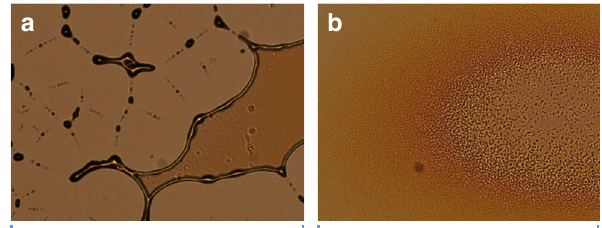
Fig. 5 In fl uence of the accumulated neutral molecule. Optical microscopy images (scale bars 540 µ m) of surfaces generated by ion soft landing of [B 12 Cl 12 ] 2- with a partial and b complete substitution of the adventitious hydrocarbons with sublimed glycine. a Partial glycine substitution led to slower and incomplete dewetting (compare with Fig. 3b), b full substitution with glycine resulted in a stable grainy layer that showed no change under ambient